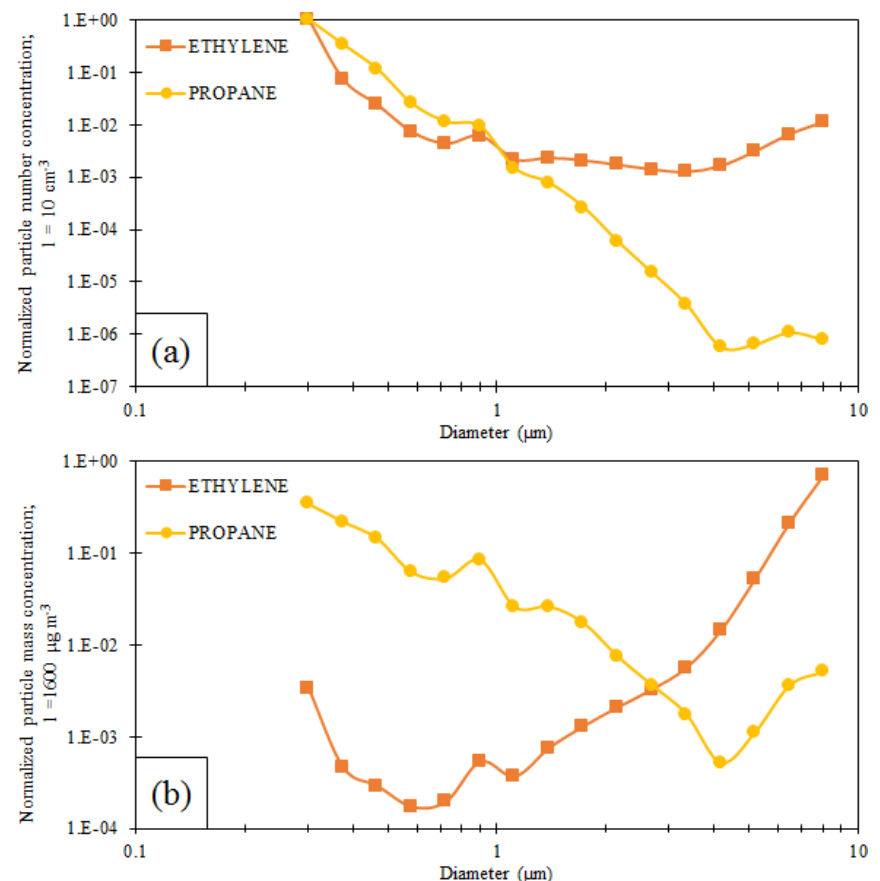
Figure 6. Particle concentration normalized to the total vs. particle diameter, as measured by OPS. Panel (a) shows the number distribution. Panel (b) shows the mass distribution. MISG was fuelled with 7Lmin − 1 of air and 75mLmin − 1 of fuel during the propane experiment and 127mLmin − 1 of fuel during ethylene experiment. No cyclone was